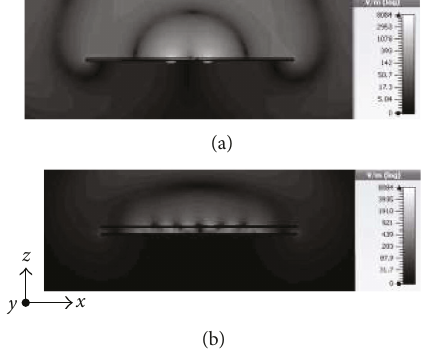
Figure 11: The simulated antenna directivity under various distances between the antenna and the superstrate.